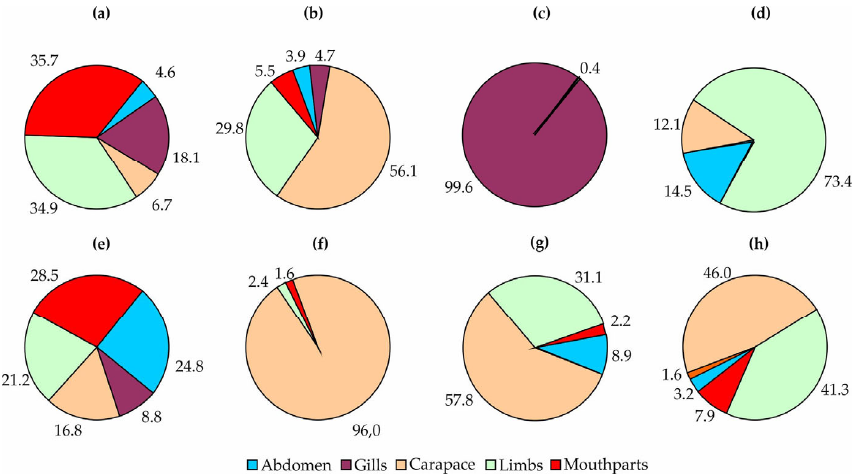
Figure 9. Localization patterns of common taxa on red king crabs from Dalnezelenetskaya Bay in summers during the period 2009–2013. ( a ) Ischyrocerus commensalis , ( b ) Ischyrocerus anguipes , ( c ) Tisbe furcata , ( d ) Hirudinea, ( e ) Mytilus edulis , ( f ) Balanus crenatus , ( g ) Bryozoa, ( h ) Hydrozoa.